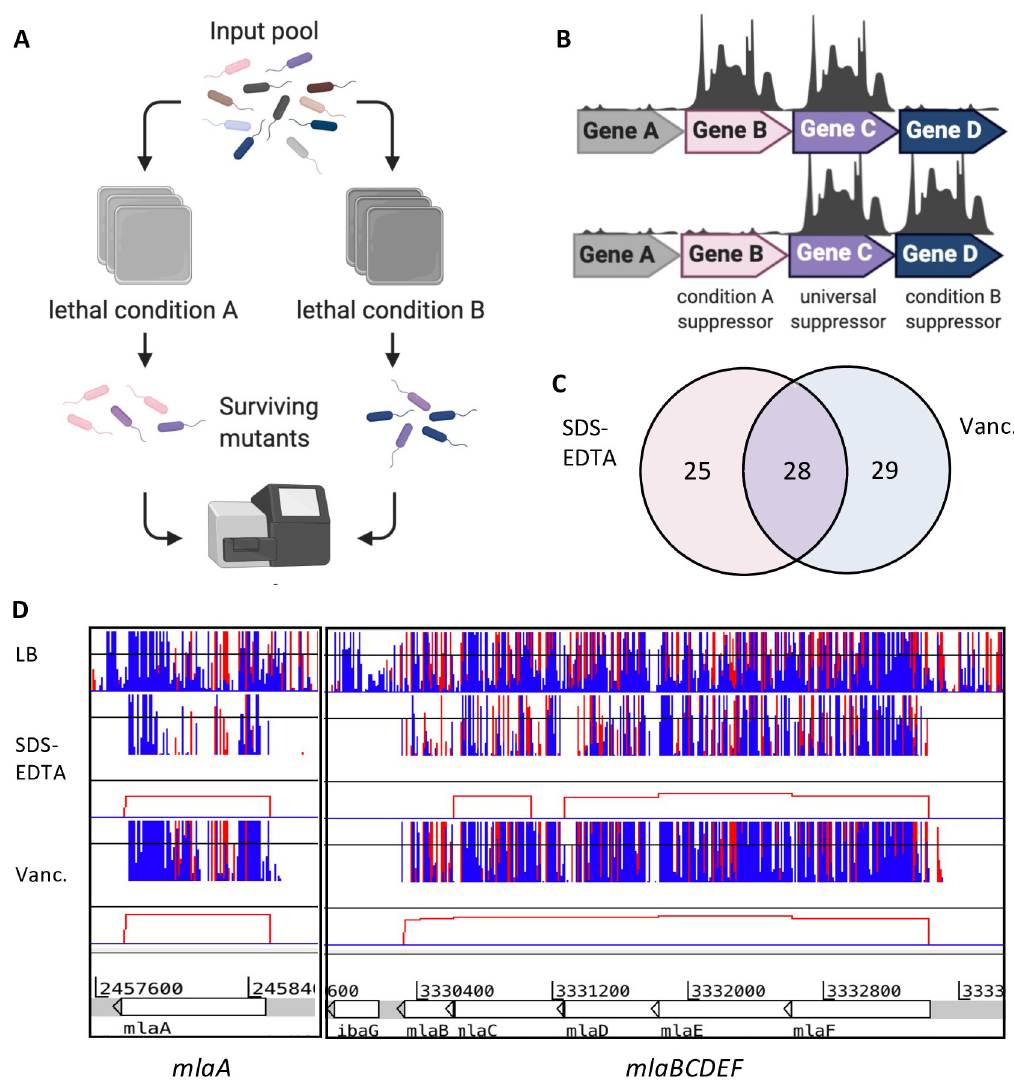
Fig 7. Identification of suppressor mutations that restore a yhcB -deletion defect. (A) Experimental overview. (B) Cartoon of output. (C) Overlap between gene-deletion suppressors identified in the vancomycin and SDS + EDTA screens. (D) Transposon insertion data for suppressor screens. Red and blue lines indicate the transposon insertion position corresponding with the transposon orientation at the point of insertion. The height of the bar corresponds with mapped sequencing read frequency. The red boxes underneath each suppressor dataset represent significant differential abundance of insertions of the condition compared to the control, identified by AlbaTraDIS. Panel A and B schematics created with BioRender.com, Panel D insertion plots visualized in Artemis